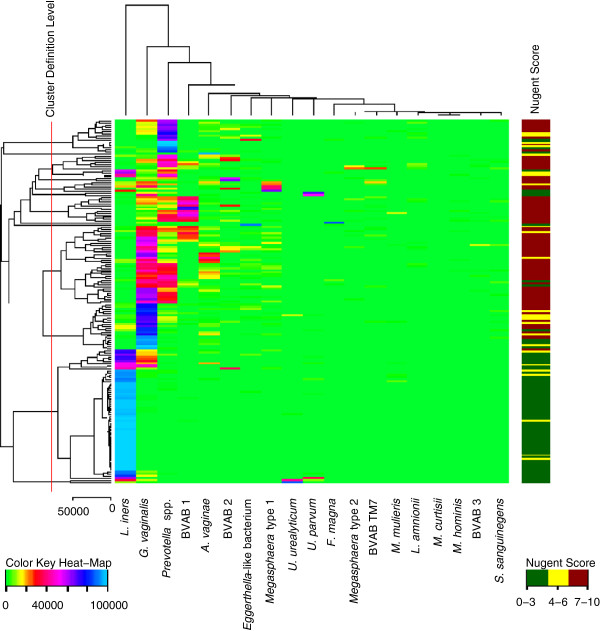
Vaginal bacterial communities. Heat-map constructed by normalising the number of 16S rRNA gene copies/ml UTM for vaginal bacteria in 177 women from Greenland with or without BV. Nugent scores are shown in the vertical column. The scale bar represents the Euclidean distance, corresponds to 50,000 and is calculated after Pythagorean metric. The colour key shows colour code and corresponds to normalised geq/ml UTM for each bacterium. The vertical red line indicates the level that was chosen for defining the clusters.